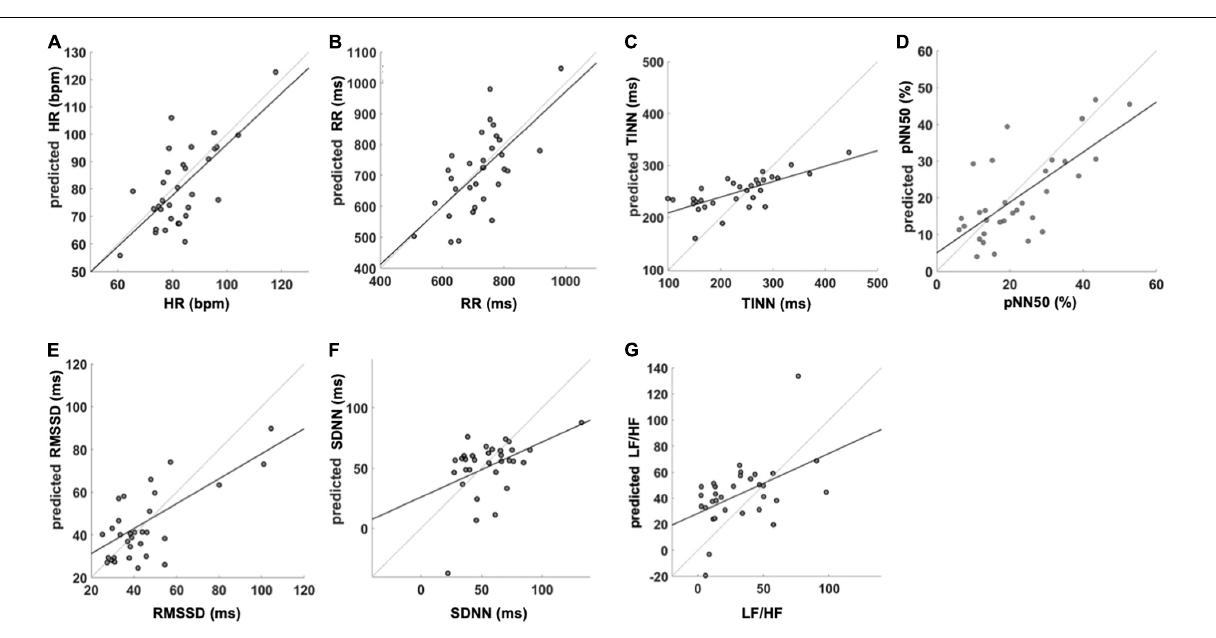
FIGURE 4 | SVR performance for the analyzed HRV variables. The figure reports the regression equation and r 2 for the prediction of (A) HR, (B) RR, (C) TINN, (D) pNN50 (%), (E) RMSSD, (F) SDNN, and (G) LF/HF. HR, heart rate; RR, the interval between consecutive R peaks; pNN50 (%), percentage of successive RR intervals that differ by more than 50 ms; RMSSD, root mean square of successive RR interval differences; SDNN, standard deviation of NN intervals; LF/HF, ratio of LF-to-HF power. The reported values are associated with the iteration closer to the mean correlation